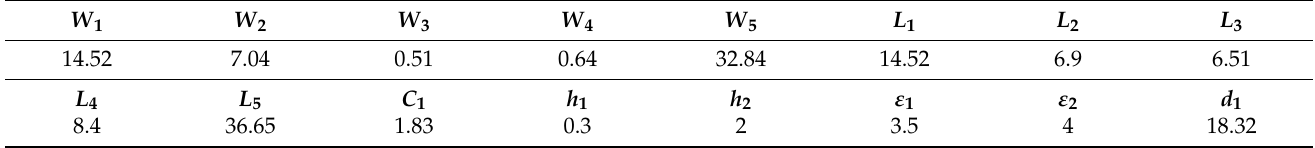
Table 1. Optimized dimensions of CLAS antenna (unit: